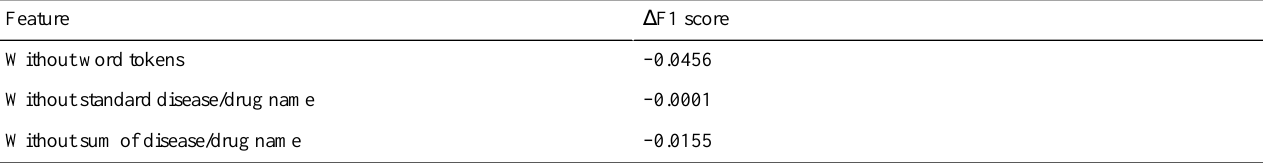
Table 3. Effects of each feature in adverse drug event–containing article extraction.